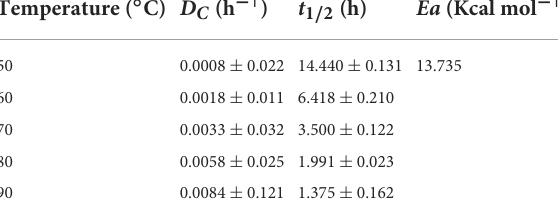
TABLE 5 D C , t 1 / 2 and Ea of the red pigments produced in cultivation submerged by Monascus ruber CCT 3802 under different heat